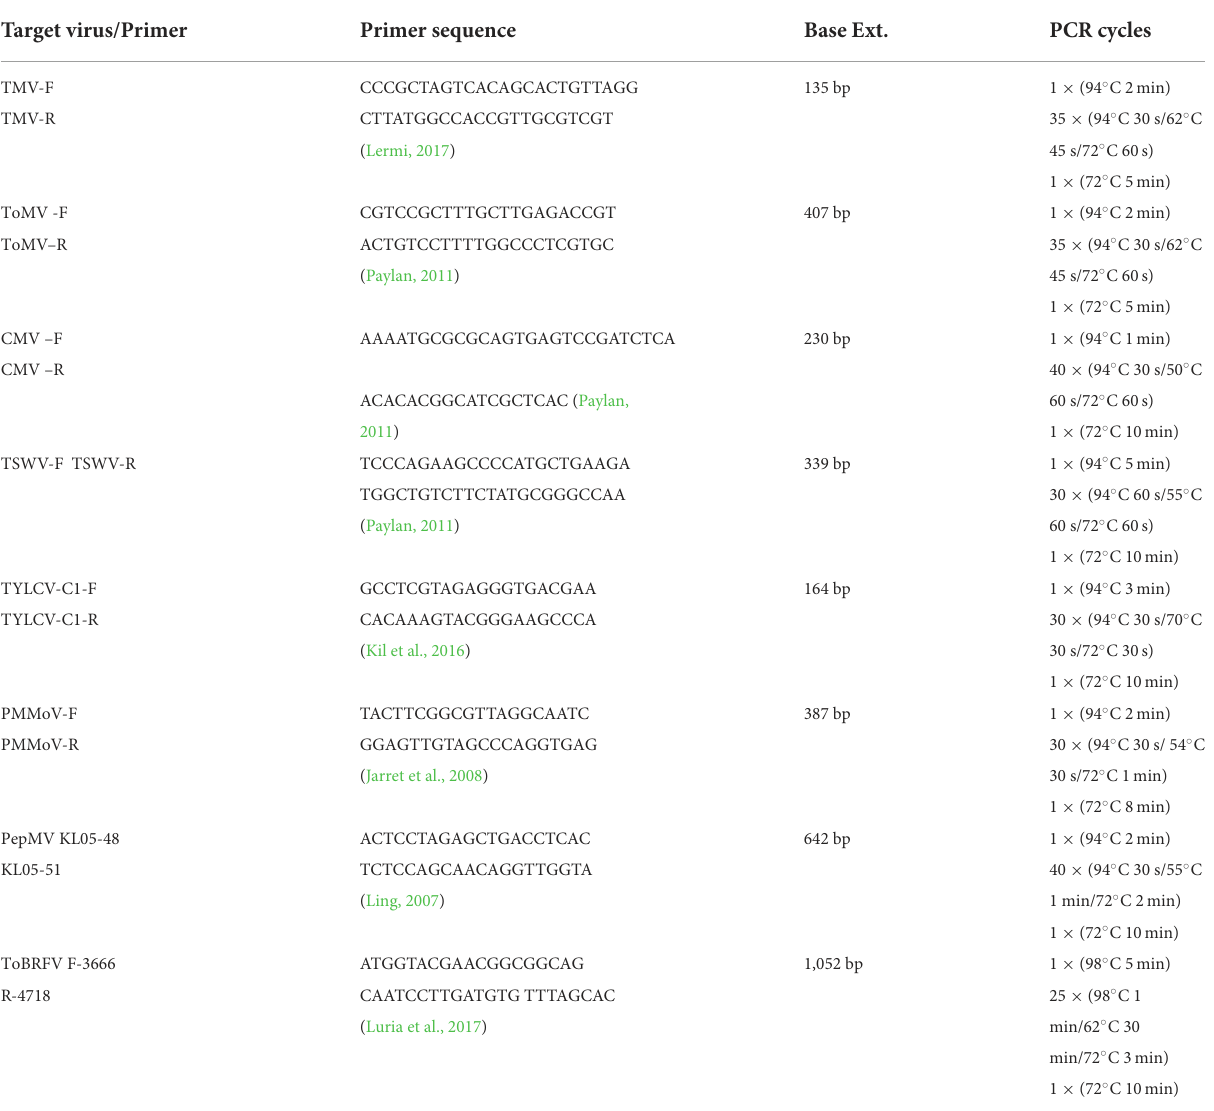
TABLE 2 Primer pairs used in PCR. Target